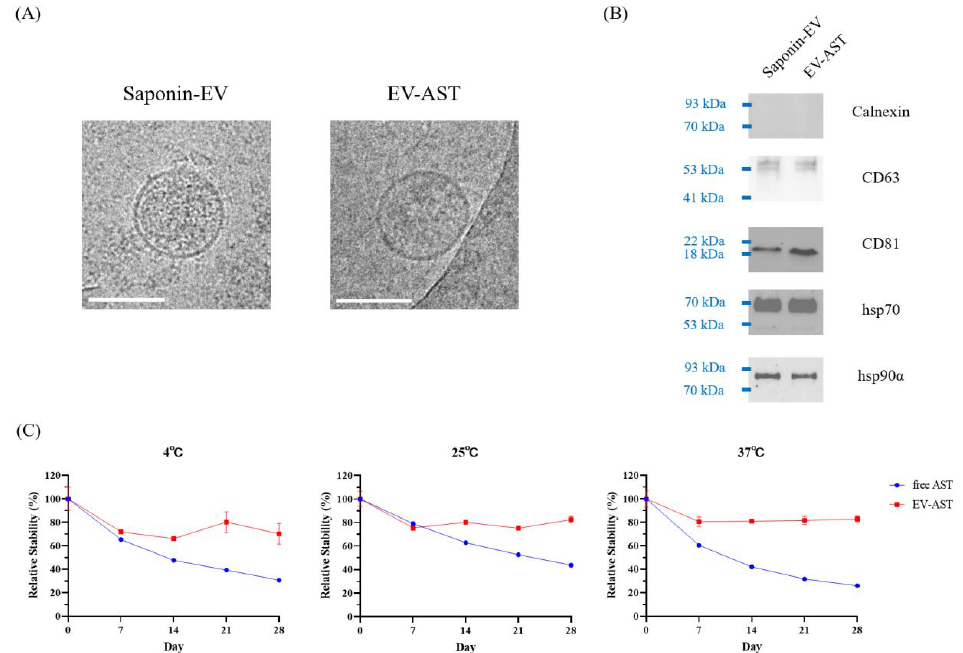
Figure 3. Enhanced stability of AST by loading it into EV. ( A ) Cryo-TEM images of saponin-EVs and EV-ASTs prepared via saponin-assisted incubation. Scale bar = 100 nm. ( B ) Western blotting results for saponin-EVs and EV-ASTs prepared by saponin-assisted incubation. ( C ) Thermal stability of free AST and EV-ASTs at 4, 25, and 37 °C. Relative stability was measured every 7 days for 28 days.